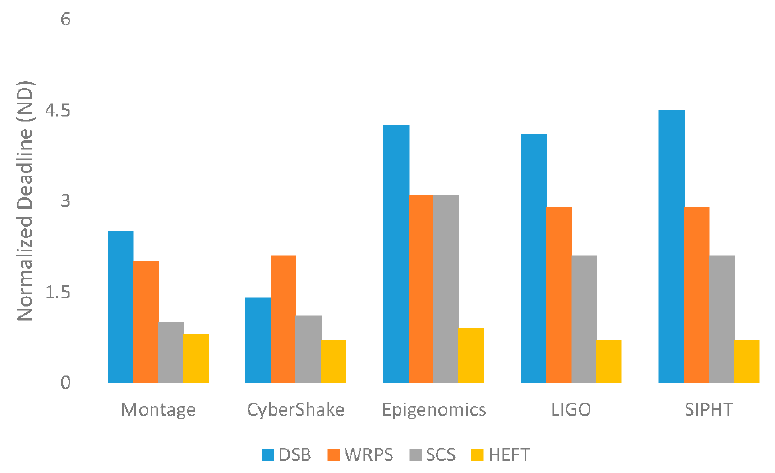
Figure 8. Normalized Deadline (ND) for each workflow with different methods.